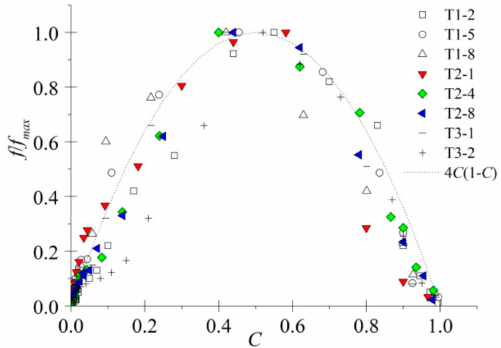
Figure 10. Relationship between the air bubble frequency and air